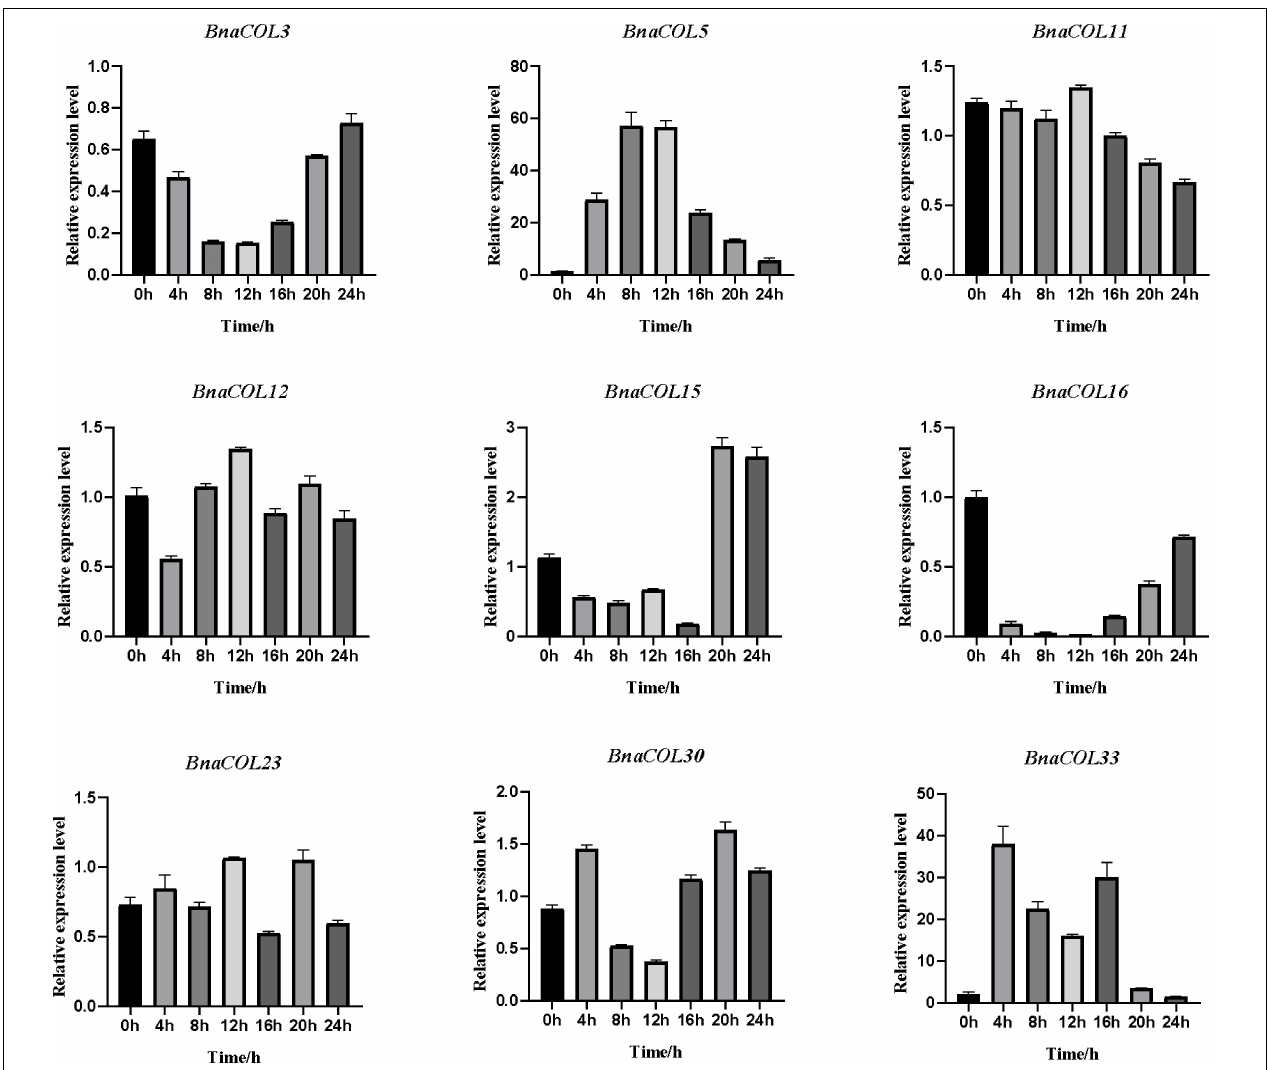
FIGURE 9 | The expression pattern of BnaCOL genes under SD conditions. Under SD (8 h light/16 h dark), the third true leaf was collected every 4 h. The error column represents the standard deviation of the three biological